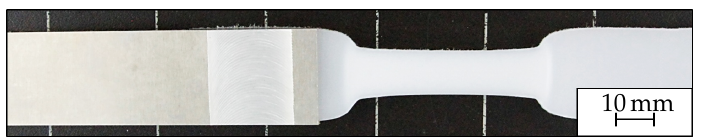
Figure 5. Typical FPJ tensile shear test specimen made of PE-HD and EN AW-6082-T6 (I-PSd) after a successful lap shear test with distinct strain hardened